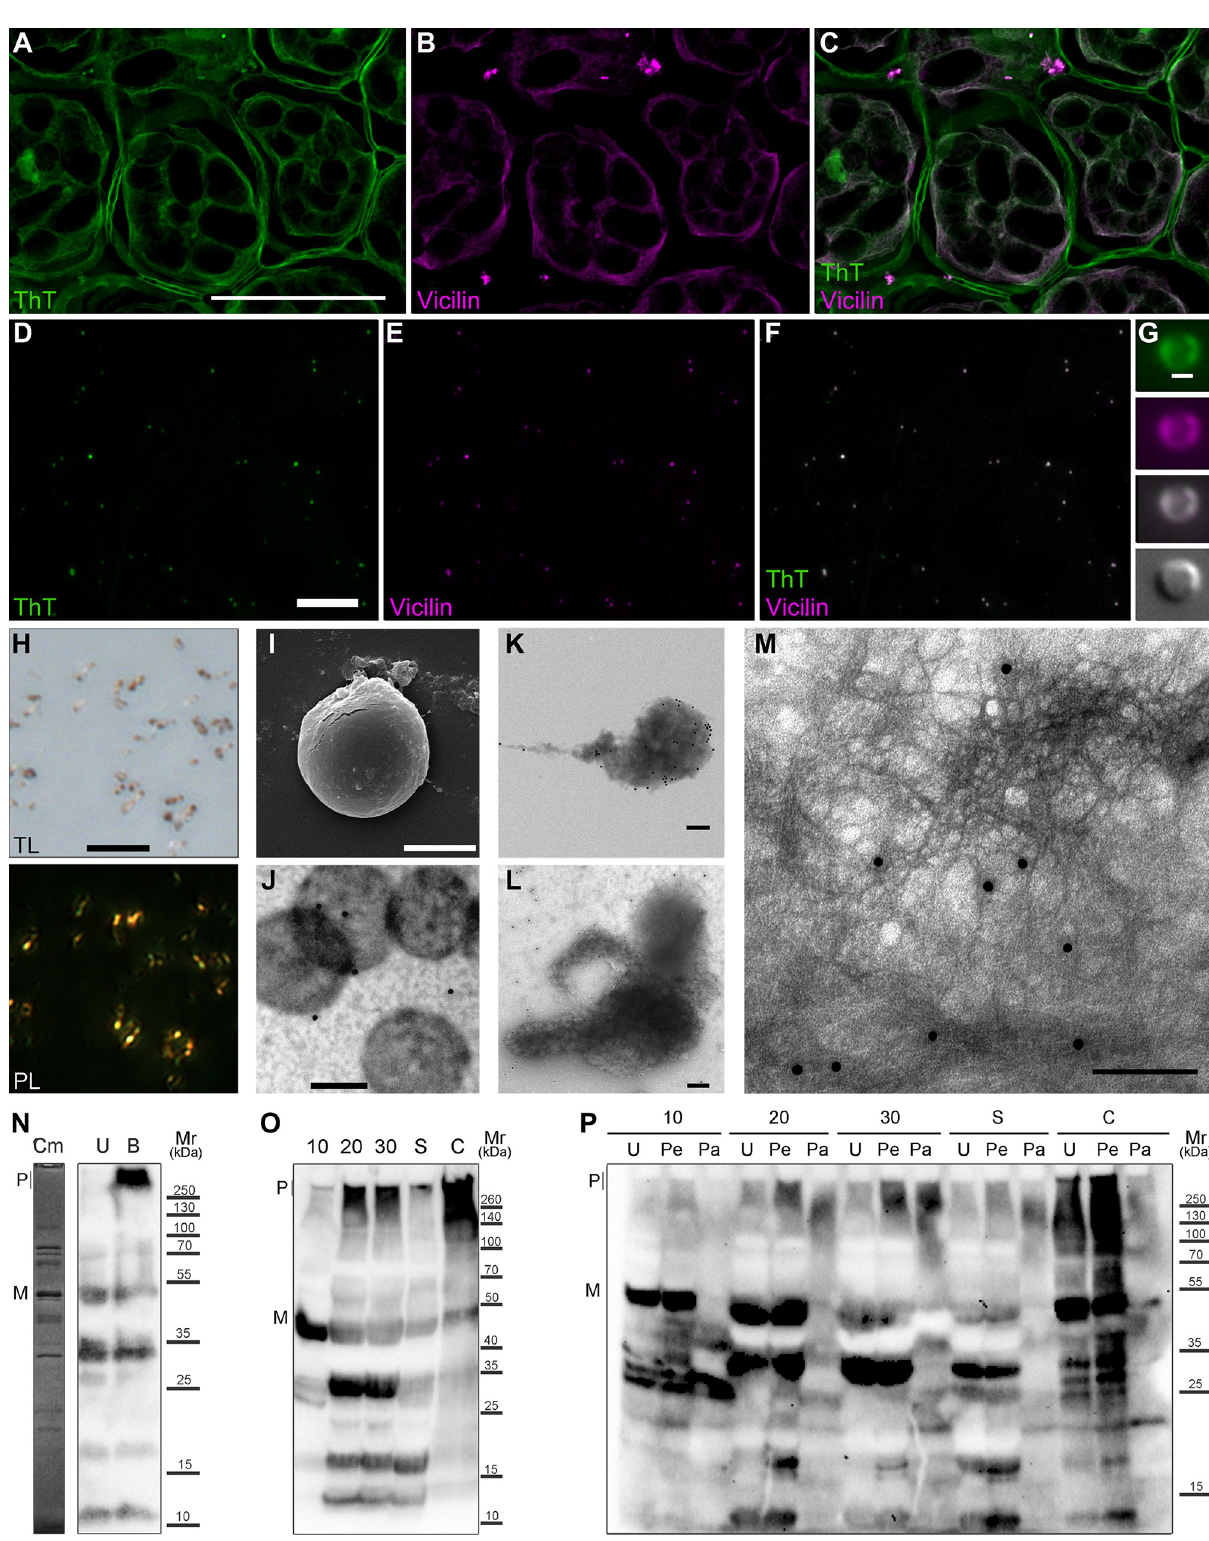
Fig 5. Vicilin forms amyloid aggregates in vivo. (A–C) In situ hybridization of anti-Vicilin antibodies with ThT on pea seed cryosections. (A) ThT channel of fluorescence (green), (B) anti-Vicilin antibody (magenta), (C) right—overlay (gray). Scale bar is equal to 100 μ m. (D–F) In situ